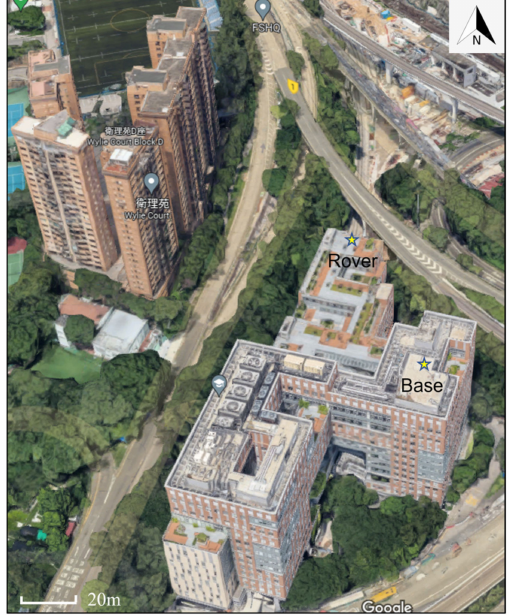
Figure A1. Location of the rover and the base